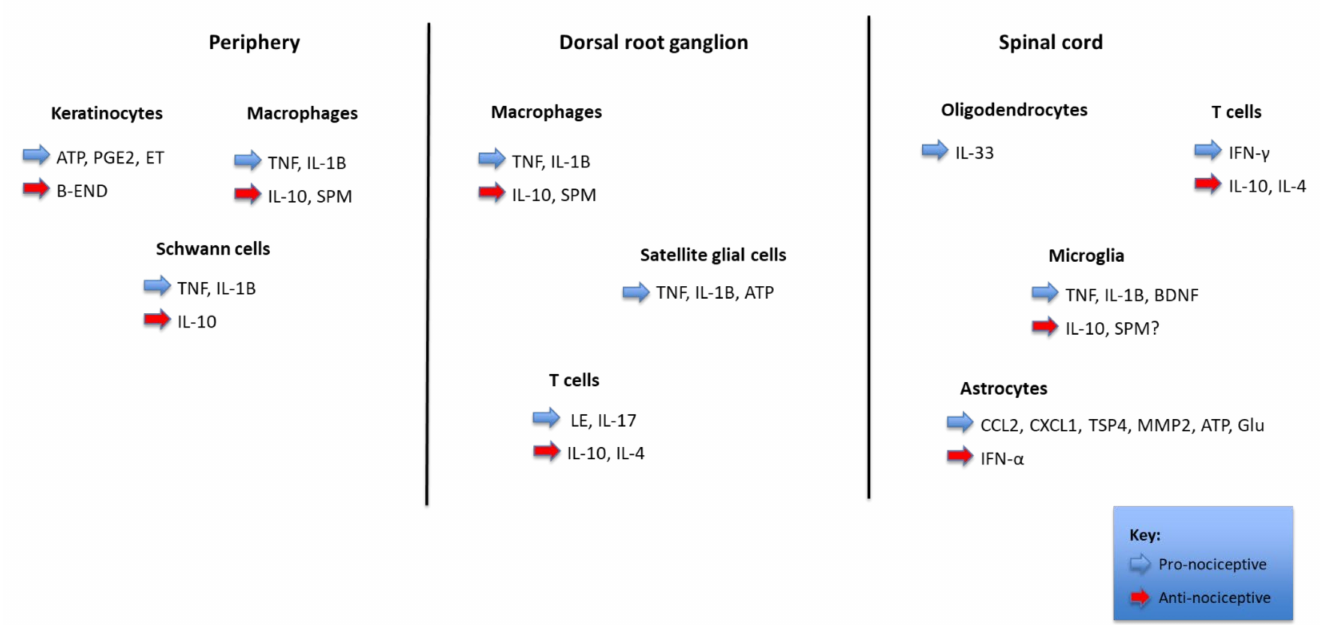
Figure 1. Pain regulation by non-neuronal cells and inflammation. The figure shows the interactions between distinct parts of a nociceptor (periphery, dorsal root ganglion, and spinal cord) with different types of non-neurons cells (keratinocytes, Schwann cells, satellite glial cells, oligodendrocytes, and astrocytes), immune cells (macrophages, T cells, and microglia), cancer cells, and bone marrow stem cells. These cells produce pronociceptive (highlighted in blue) and antinociceptive (highlighted in red) mediators, which modulate the nociceptor sensitivity and excitability through binding to their respective receptors. In the spinal cord dorsal horn, the central terminal of the nociceptor forms a nociceptive synapse with a postsynaptic neuron to mediate pain transmission in the Central Nervous System